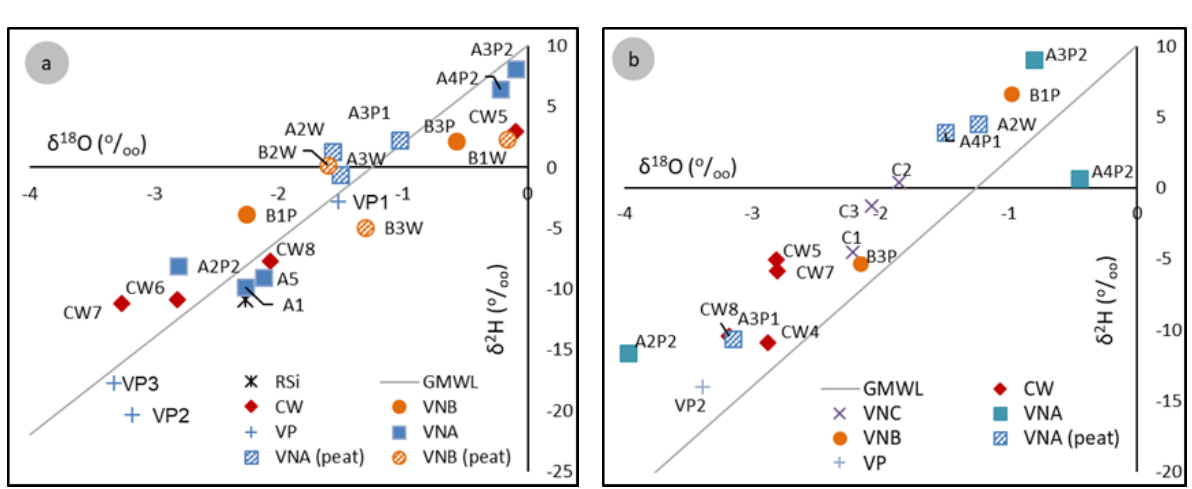
Figure 8. (a) Isotopic compositions of the water samples from the Vasi peatland complex in March 2015. (b) Isotopic compositions of the water samples taken in April 2015 after a 5-mm rainfall event. The VNC transect was measured only in April.